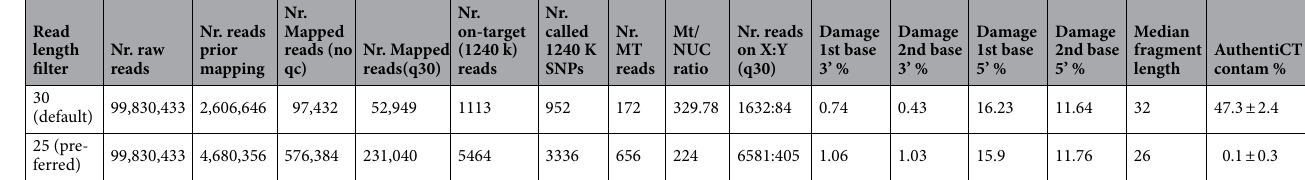
Table 1. Eager statistics of deeper shotgun sequenced data from the hair sample KDR001.B0101.SG1.2 with different length filter cut-off. We performed contamination tests using AuthentiCT, which is designed for sequences from single-stranded